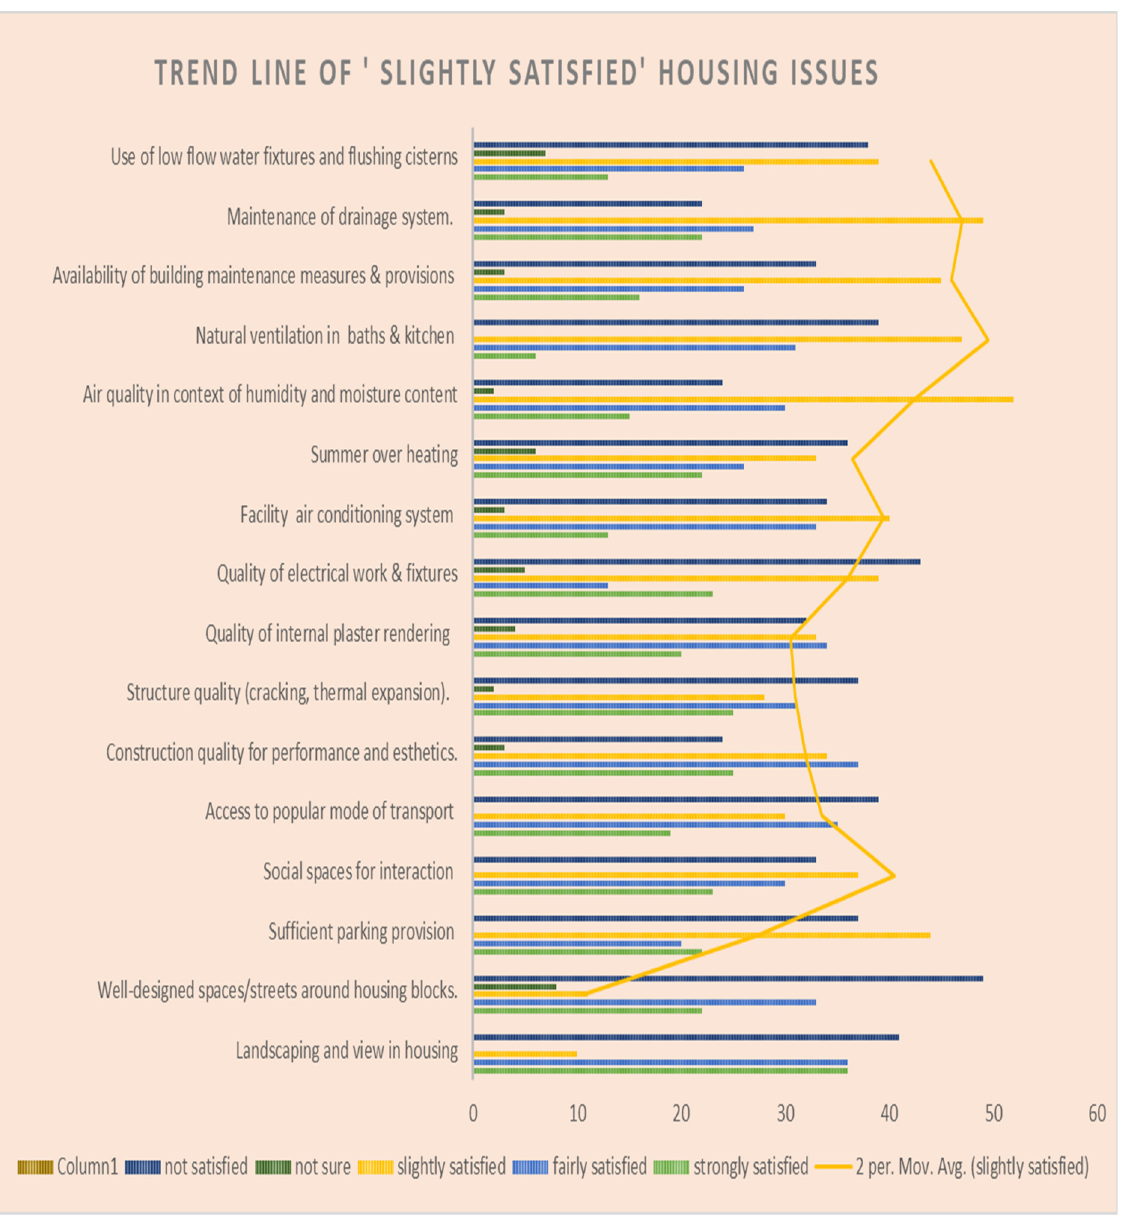
Figure 7. “Slightly satisfied” trend.